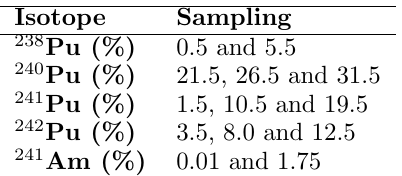
Table 7. Diffusion database isotopic perturbations. Isotope